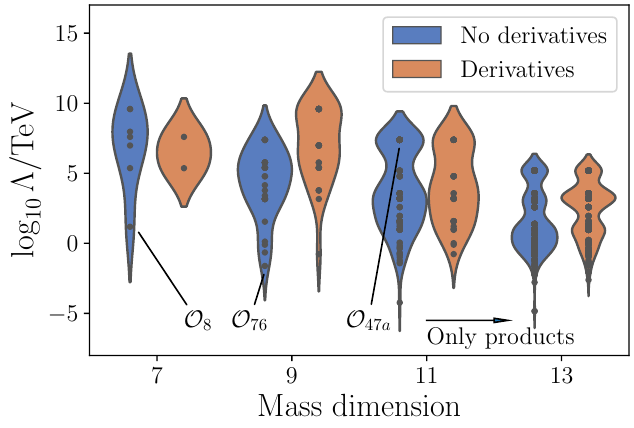
Figure 6. The figure shows smoothed histograms of the number of operators that have an estimated upper bound of Λ on the new-physics scale. Black dots generally represent more than one operator. The strips are broken up by mass dimension and whether the operators contain derivatives or not. We assume unit operator coefficients and the dominance of third-generation SM-fermion contributions in the closure diagrams. Operators containing no derivatives (blue) are separated from those containing one derivative (orange). Those containing more than one derivative are not included in the figure, since in most cases these come about at next-to-leading order in the EFT expansion, and therefore imply the same Λ values as the lower-dimensional operator with two fewer derivatives. The dimension-eleven operators containing one derivative and all of the dimension-13 operators shown are constructed from the lower-dimensional operators in our listing only as products. This means that the set of operators plotted above that do not feature in table 8 are incomplete. However, we do not find that similar product-type operators at dimensions nine and eleven give special estimates for the neutrino mass or Λ , and so we expect these results to be representative of the true situation up to mass-dimension 13. The general decrease in Λ with increasing operator mass dimension is evident in the figure. The most suppressed closures tend to be of non-derivative operators. By mass-dimension eleven it becomes clear that a class of operators, those with the structure shown in eq. (4.1), are less suppressed than the